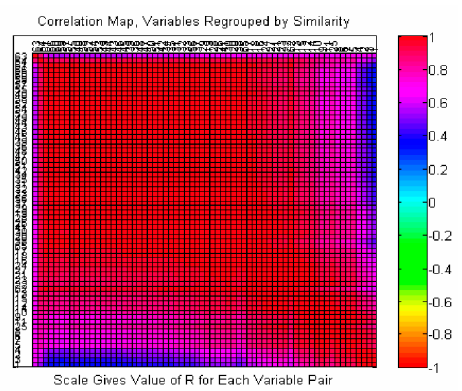
Figure 3. UV spectrum correlation heat-map of 73 features extracted from diode array detector (DAD) data.